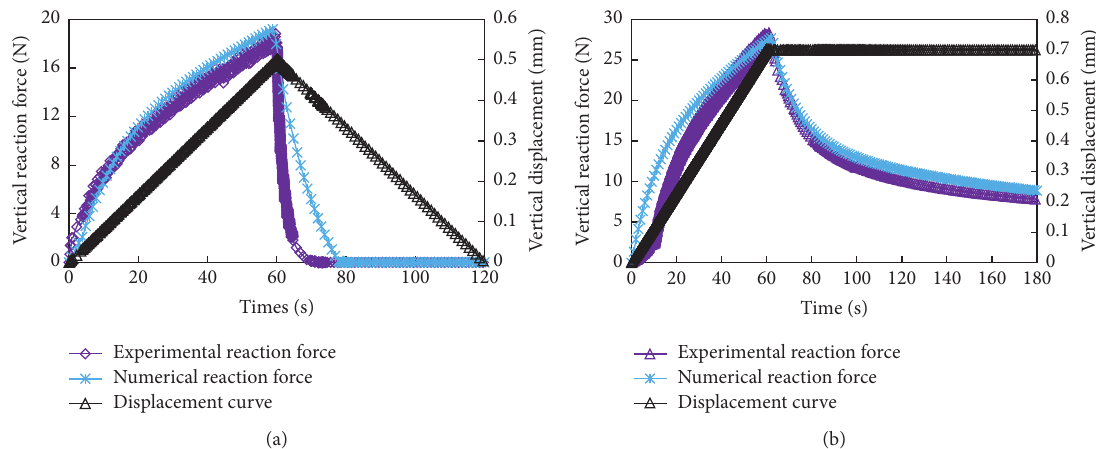
Figure 4: Simulated and experimental bending results of displacement-based loading, (a) loading and unloading and (b) loading and holding steady-state.